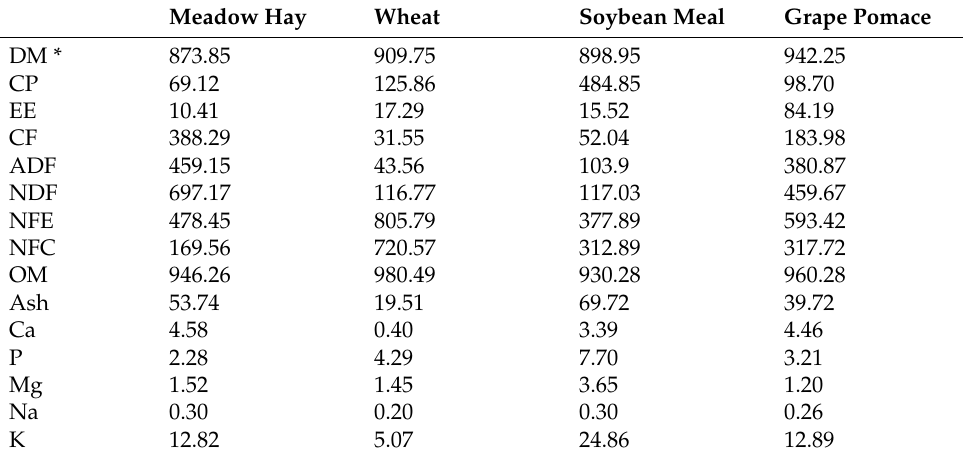
Table 3. Chemical composition of feed components. Meadow Hay Wheat Soybean Meal Grape